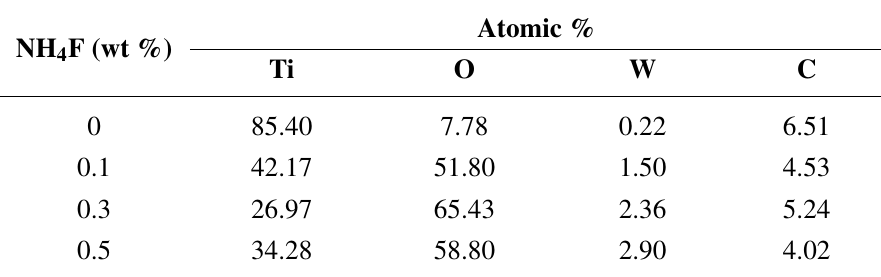
Table 2. Energy-dispersive X-ray elemental analysis of WO 3 -loaded TiO 2 nanotubes.